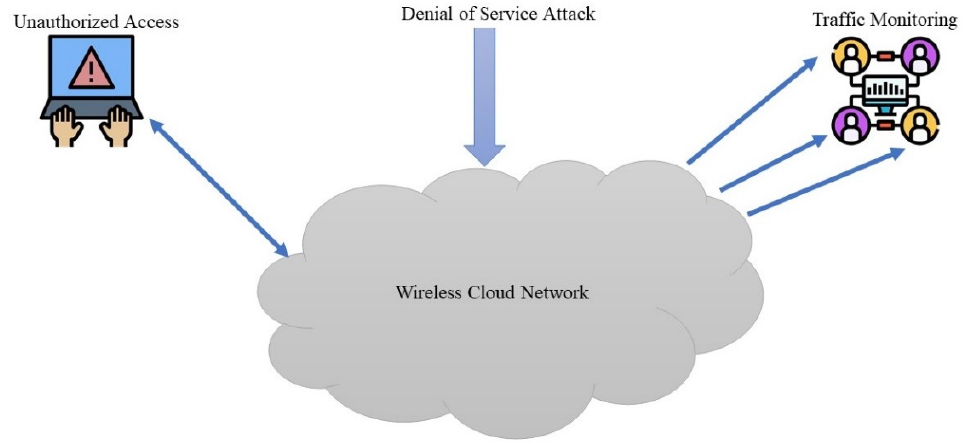
Figure 6. Network layer attacks.